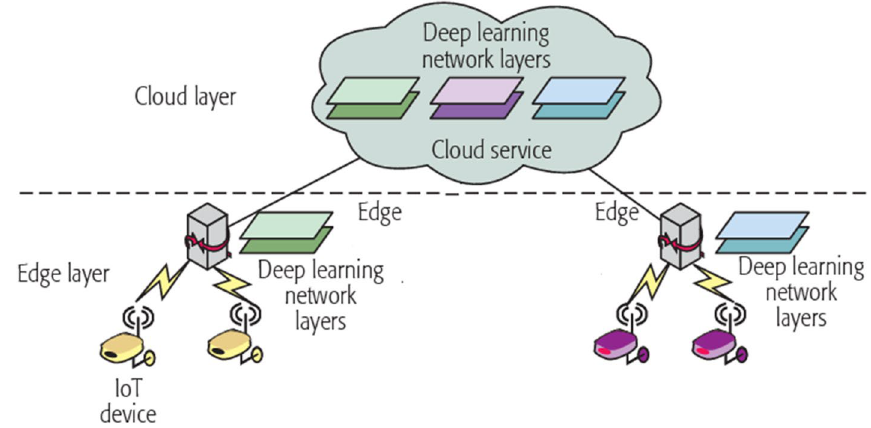
Fig. 6 The proposed edge-cloud deep learning architecture